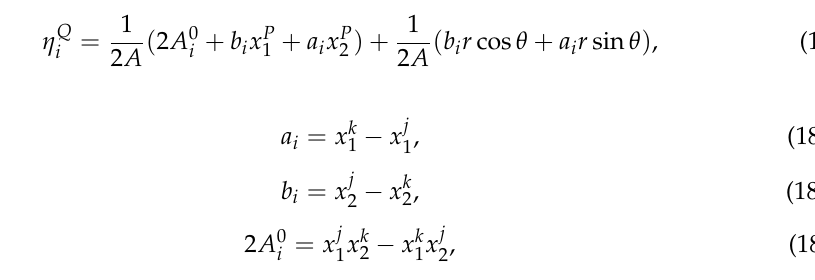
Table 3. Integration results of the dual singular coefficients ( ψ , χ , ∂ψ